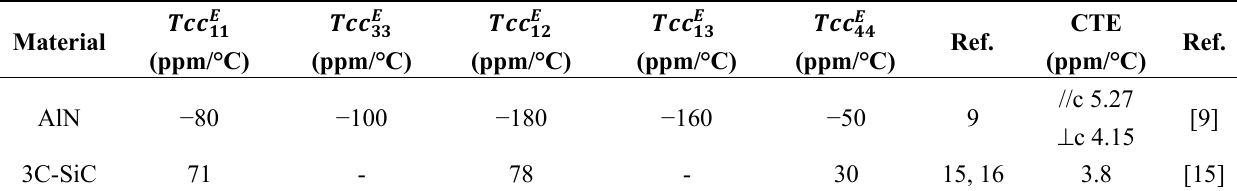
Table 1. The SiC and AlN CTE and the temperature coefficients of the elastic constants used in the numerical